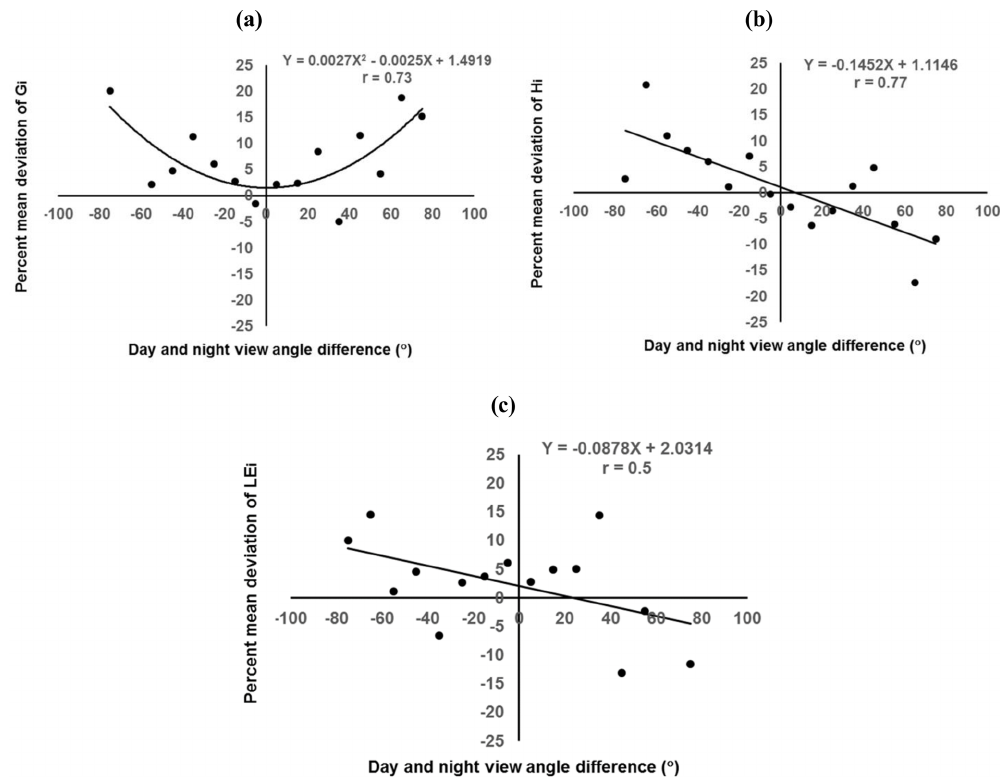
Figure F1. Dependence of STIC-TI model flux error in terms of mean percent deviation from measurements of day–night view angle differences of MODIS Aqua expressed as a mean of the 10 ◦ bin for (a) G i , (b) H i , and (c) LE i